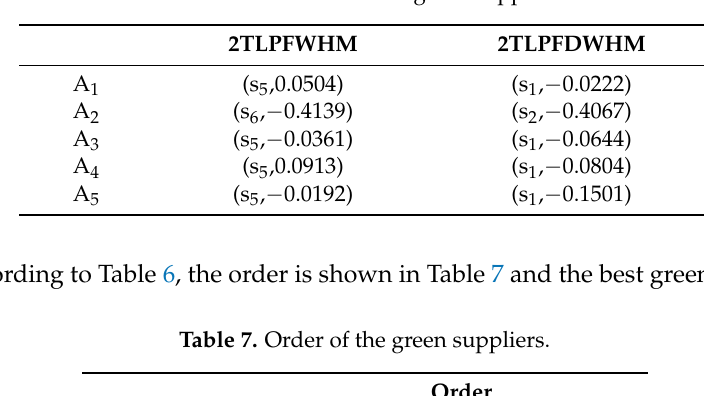
Table 6. The scores of the green suppliers.